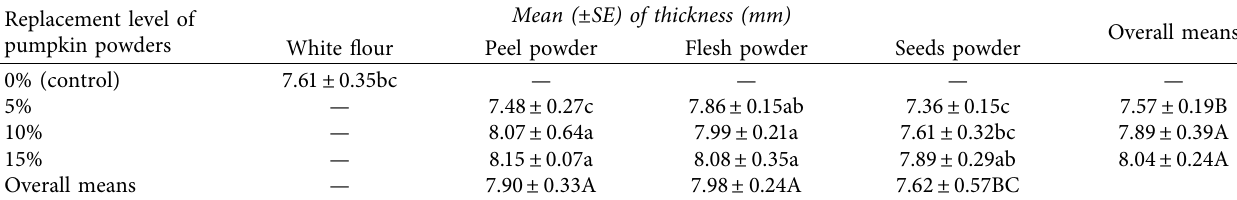
Table 8: Tickness (mm) of biscuits with diferent replacement levels of pumpkin peel, fesh, and seeds powders. Replacement level